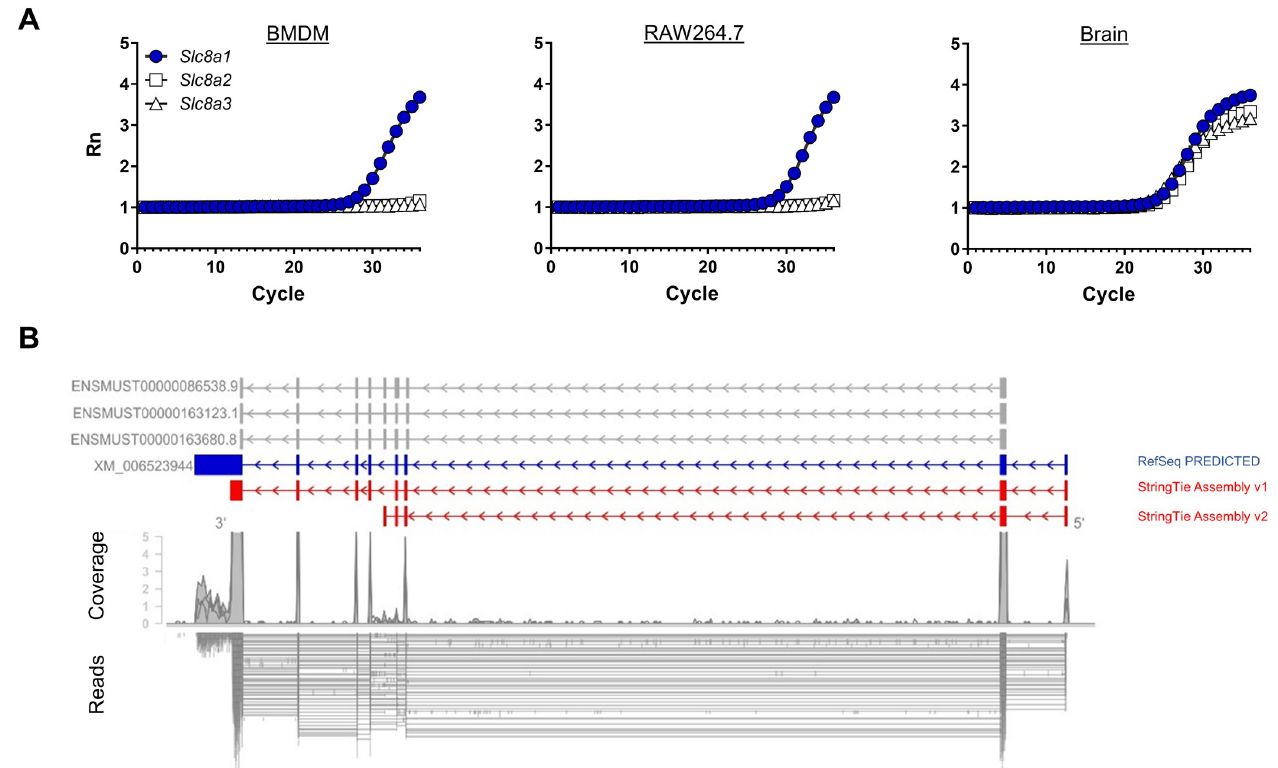
Fig 3. M F s express a novel Slc8a1 splice variant. (A) A representative real-time amplification plot of Slc8a1 , Slc8a2 , and Slc8a3 in BMDMs, RAW264.7 M F s, and brain tissue out of two experiments. (B) Shown are the alignments of RNA-seq reads of BMDMs and their coverage with annotated (gray;